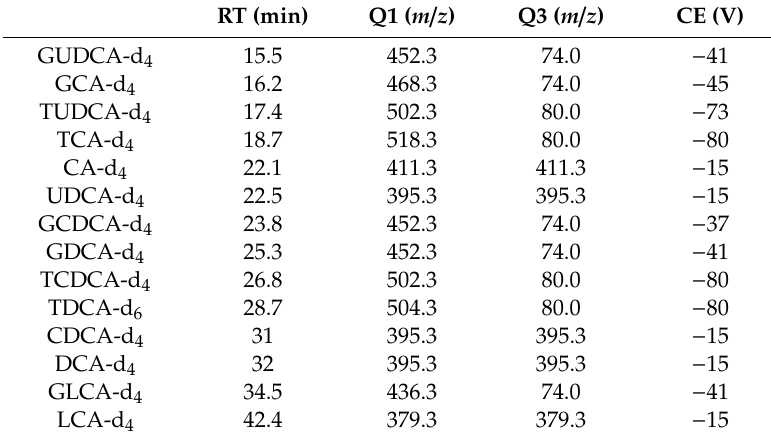
with their respective retention